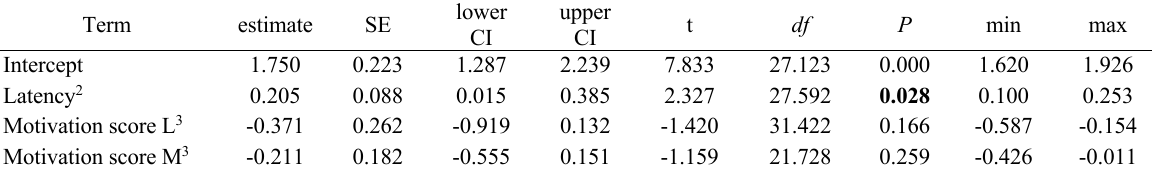
Motivation score M 3 -0.211 Note. 1 Results displayed are estimates and standard errors, together with confidence limits, results of tests, and the range of estimates obtained when dropping levels of random effects one at a time, 2 z -transformed to a mean of 0 and a standard deviation of 1; mean and SD of the original variable were 1.284 and 0.436, respectively, and 3 coded as factor with high (H) being the reference